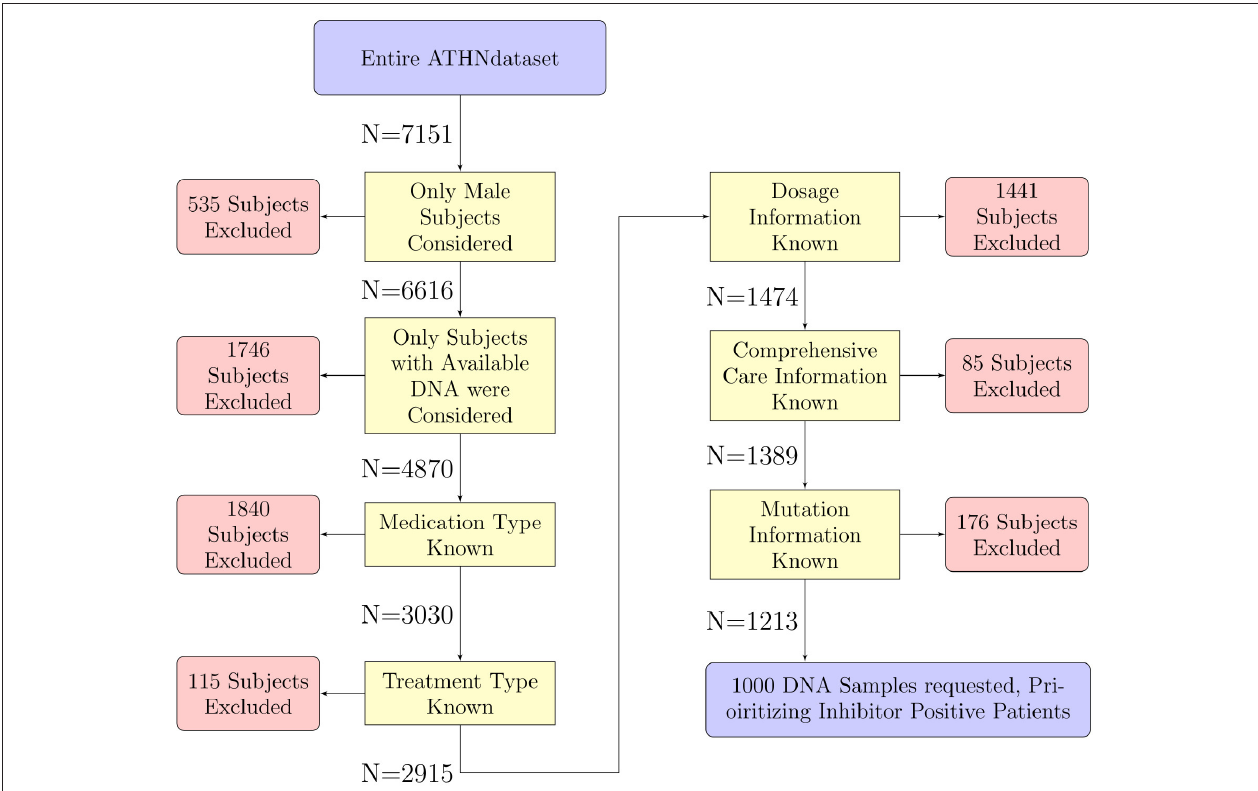
FIGURE 1 | Selection of participants for HLA typing. The 7,151 participants in the entire ATHNdataset were filtered to select participants suitable for further analysis. We have filtered out participants for sex, availability of DNA for HLA-typing, and lack of clinical or genetic information. There were 1,213 participants which met all our criteria. One thousand of these participants’ DNA were sent for HLA